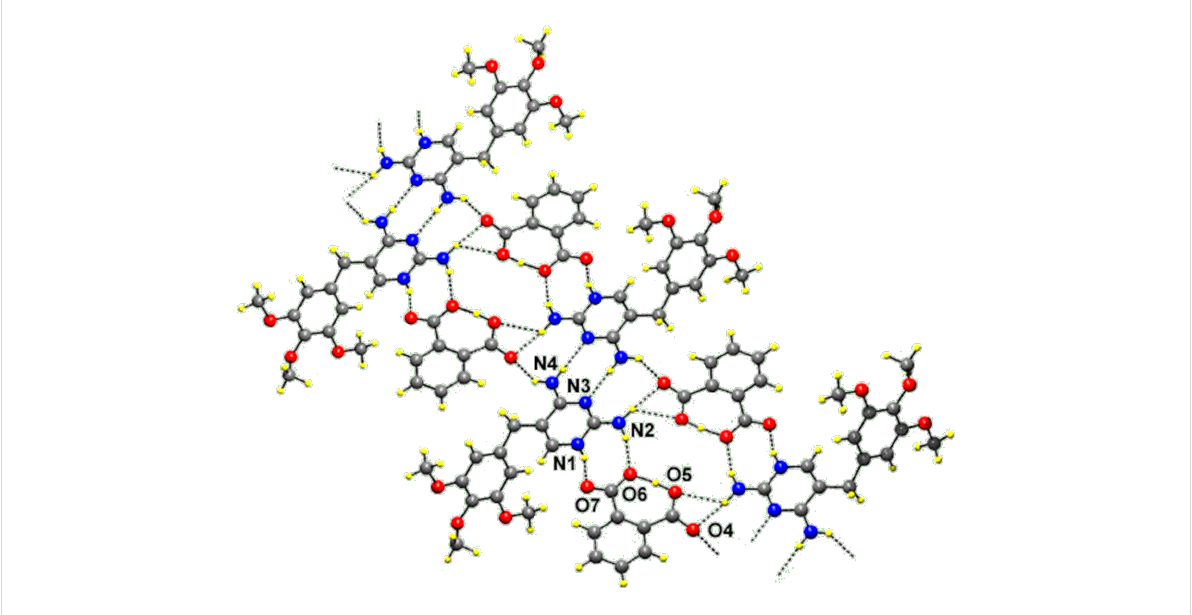
Figure 5: The hydrogen-bonded supramolecular ladder in the compound 1 .